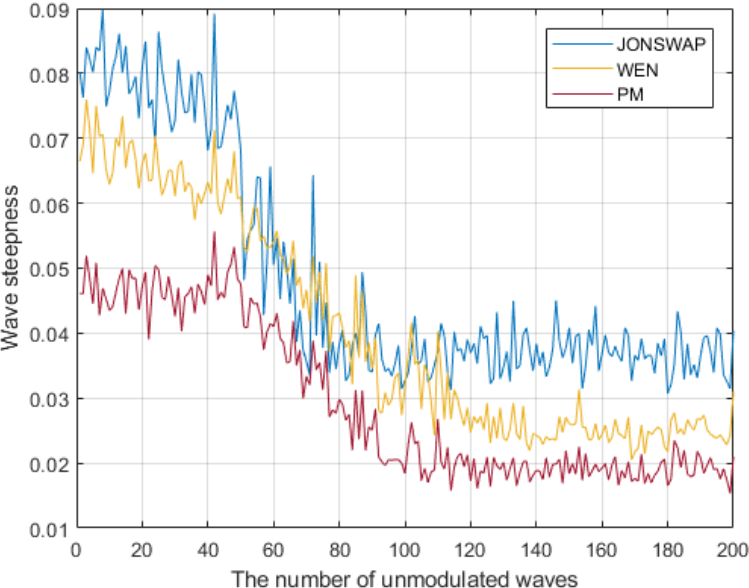
Figure 3. Wave steepness values of freak waves generated by different wave spectra for different numbers of unmodulated waves.